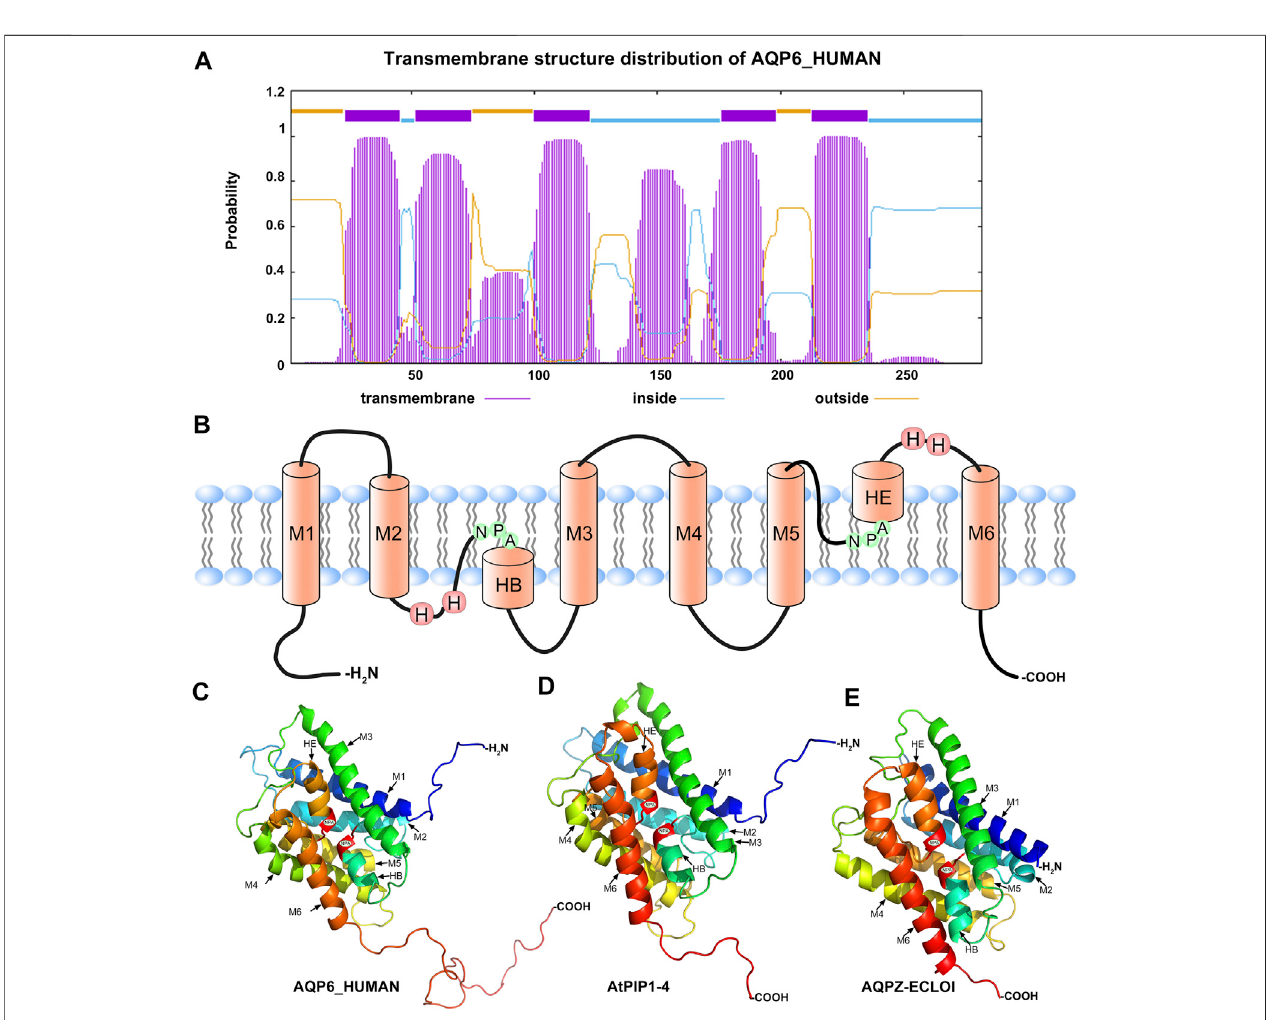
FIGURE4| ThestructureofAQPs (A) ThepredictiondistributionofthetransmembranestructureforAQP6_HUMAN (B) modelofthestructureofanAQPshowing the principal features of the protein, NPA: asparagine-proline-alanine motifs; M1-M6: the transmembrane structure (C – E) 3D constructure of AQP6_HUMAN, AtPIP1-4 and